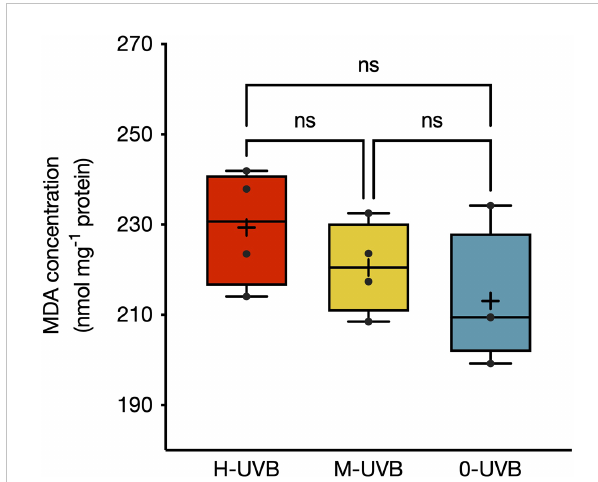
FIGURE 4 MDA concentrations (in nmol mg -1 protein) in Stylophora pistillata fragments at the end of the experiment performed on 6 – 7 th October 2016. Coral fragments were incubated in either full UVB (red), medium UVB (yellow), or UVB removal (blue) conditions. Boxplots indicate 95% CIs. Horizontal lines inside the boxplots represent medians, while crosses indicate means (n=4). Tukey ’ s pairwise comparison results are indicated above boxplots (ns = non- signi fi cant).